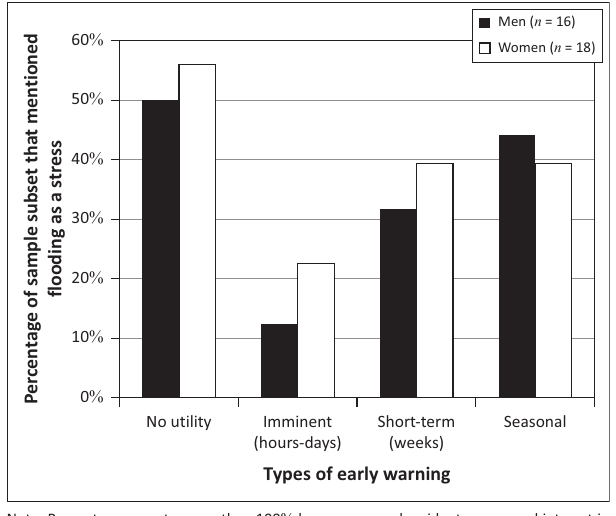
FIGURE 7: Types of desired early warning in Kasaya.